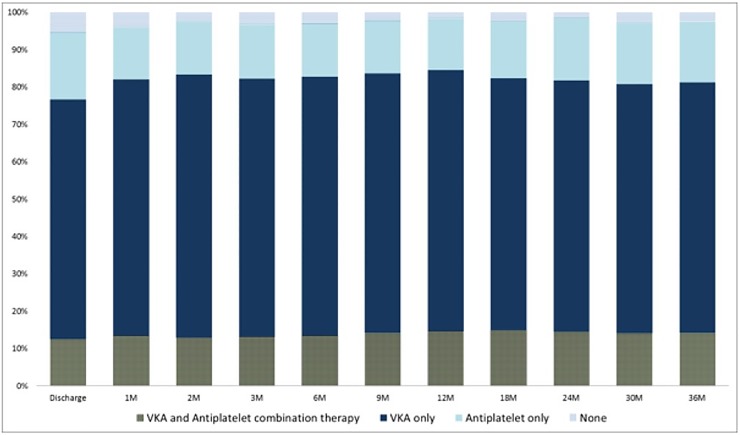
Antithrombotic use at each time point during the 3-year follow-up (Patients with no information were excluded from the denominators.).M indicate month(s); VKA vitamin K antagonists.